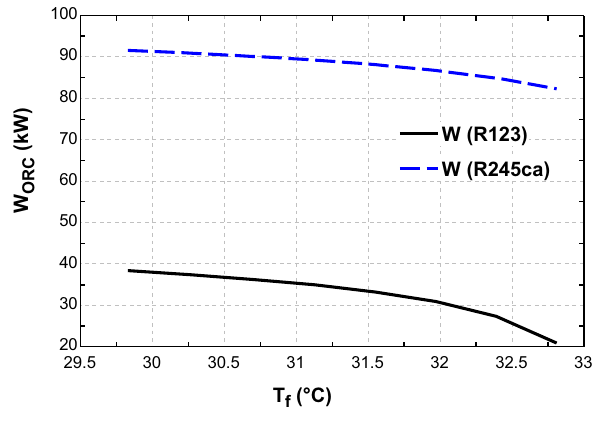
Fig. 8 The effect of inlet water temperature on output power in differ- ent working